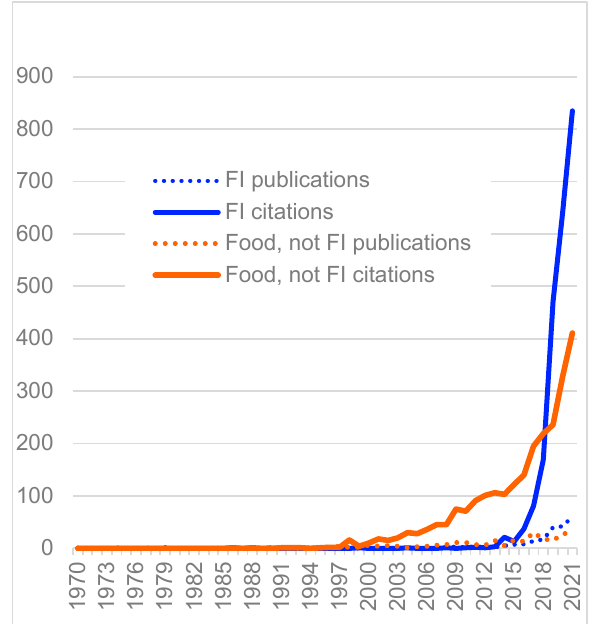
Figure 3. Trends in publications and citations for food insecurity (FI), and for food environment, food choice, diet, and health, on college and university campuses. © D.A. Cleveland, used with permission. Data from Google Scholar search of title terms, 9 April 2022: FI : ((food security) or (food insecurity) or hunger) and ((higher education*) or universit* or colleg* or campus*); food, not FI : (food* and (environment* or choice* or diet* or health*)) and ((higher education*) or universit* or colleg* or campus*) not ((food security) or (food insecurity) or hunger).